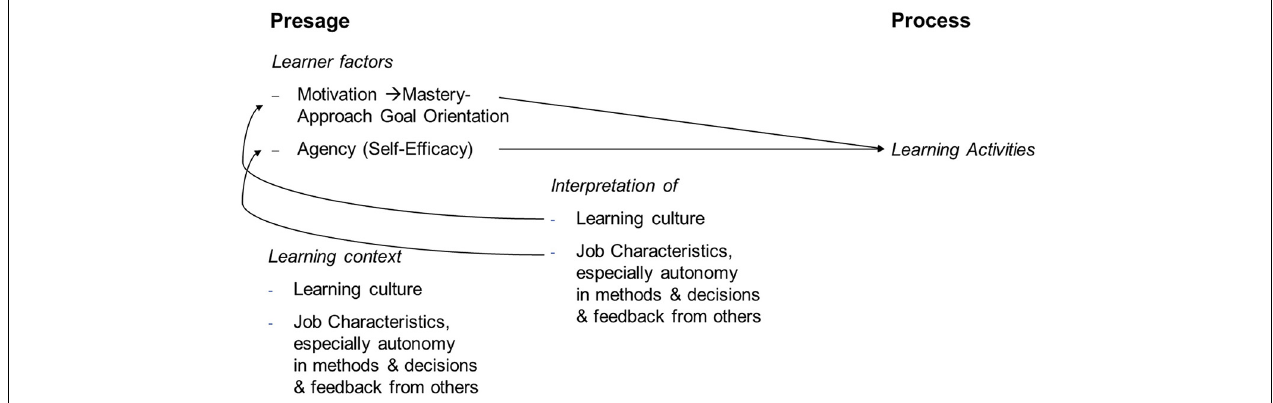
FIGURE 4 | Selected variables of the 3-P model (Tynjälä, 2013) with highlighted study findings. Contrary to expectations, there was no direct path from perception of context to learning activities, only an indirect path over motivation and